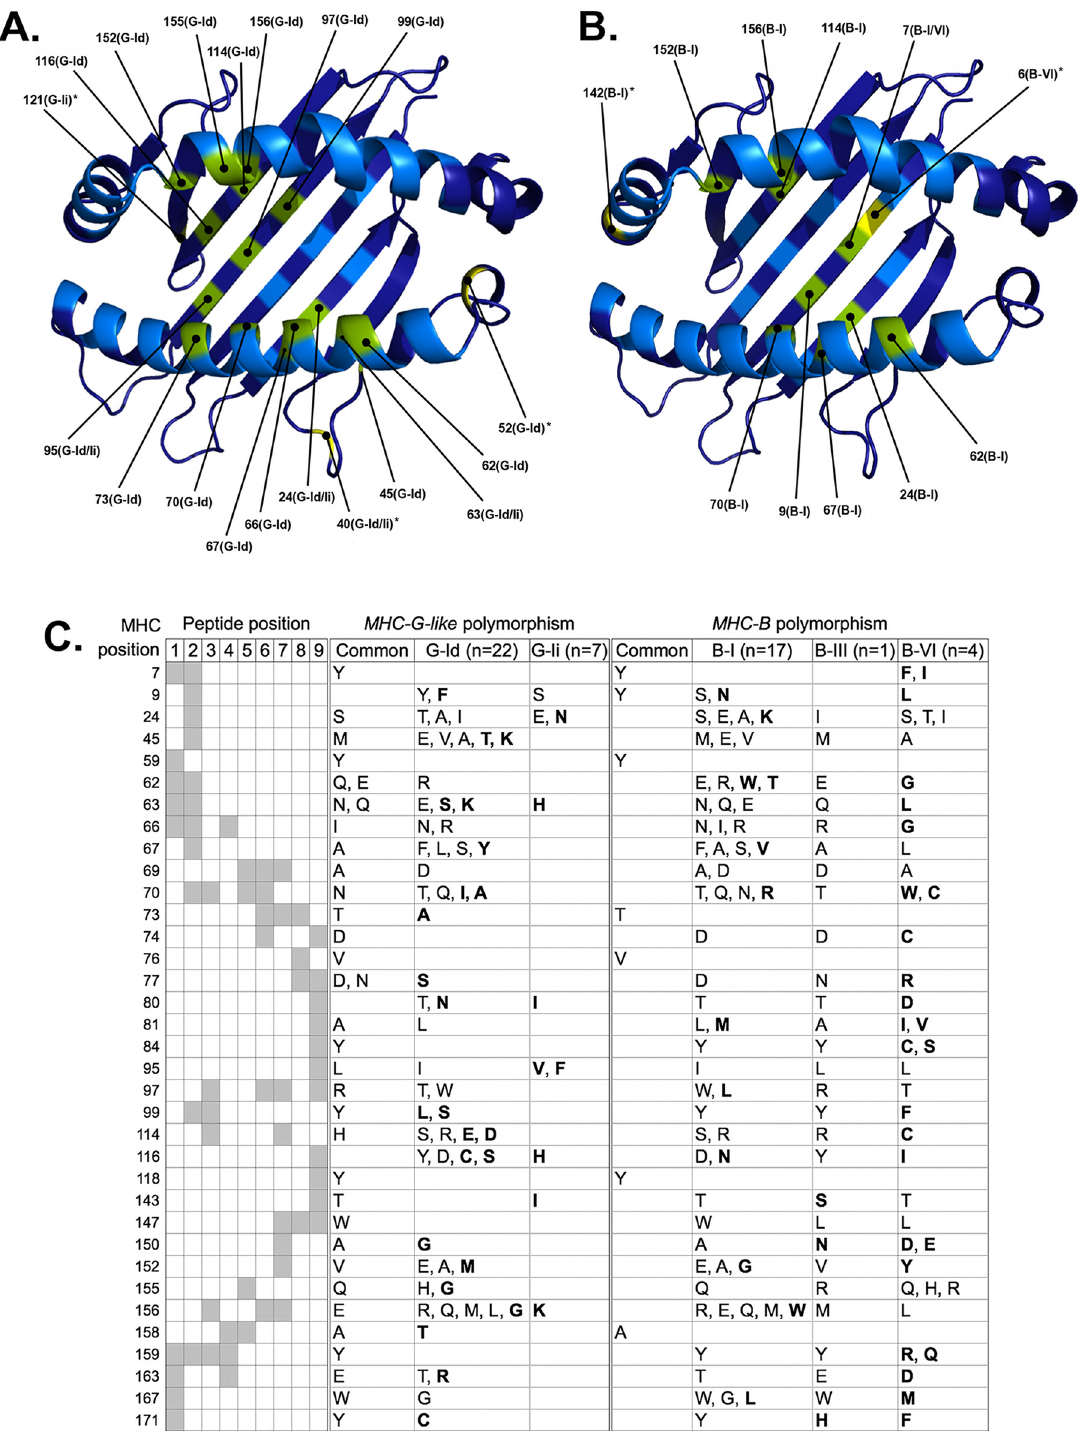
Fig 6. Natural selection has promoted the diversification of C . albifrons MHC class I loci at PBR positions predicted to interact with the processed peptide. PBR residues evolving under positive selection in Platyrrhini MHC-G-like (A) and MHC-B (B) lineages are indicated on the structural model with their corresponding positions. In parenthesis next to the position number is indicated the particular lineage where positive selection was detected. Residues colored in green are positively selected positions predicted to contact the peptide, whereas residues colored in yellow and marked with an asterisk are positively selected positions that do not contact the peptide. C, variability of MHC-G-like and MHC-B positions that interact with the processed peptide within